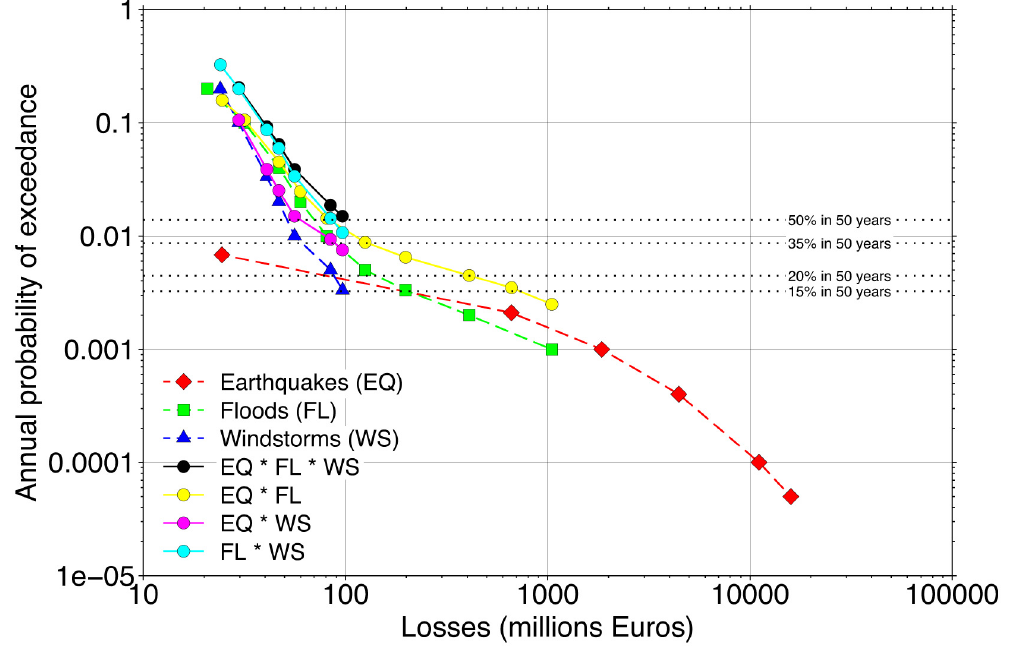
Figure 1. The individual risk curves for the three main hazards (earthquakes - EQ, floods - FL, windstorms - WS) that affect Cologne, as pre- sented by Grünthal et al. [2006], and their various combinations derived using Equation